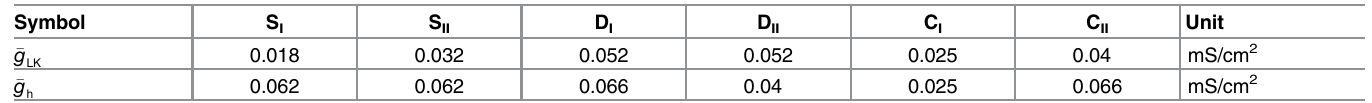
Table 1. Parameter settings for the isolated thalamus. Symbol